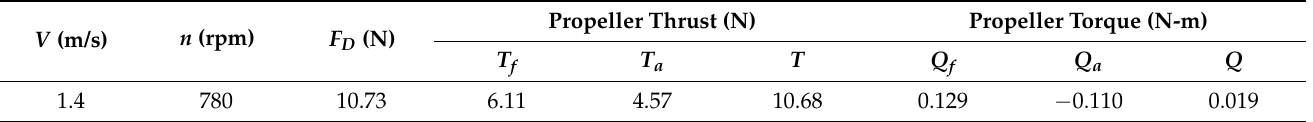
Table 4. Calculation results of the self-propulsion state of the maneuverable AUG with the CRP.